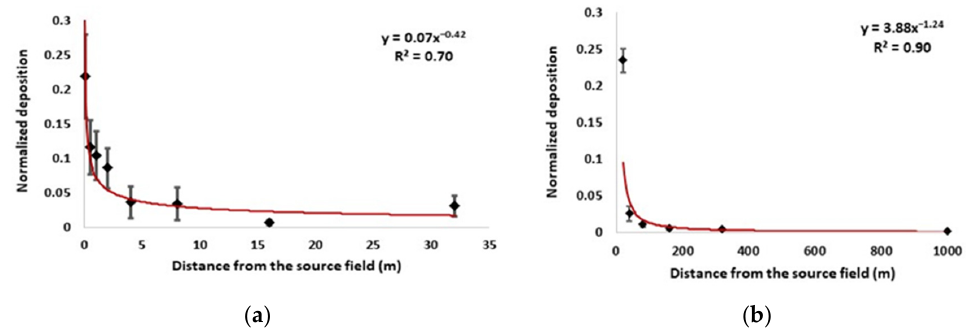
Figure 9. Normalized seed deposition along the downwind direction in the field experiments; x-axis was distance from the source field edge (seed deposition was normalized by the source strength; the diamonds are means and bars are standard deviations; red line is the fitted trend line). ( a ) Normalized seed deposition along the downwind direction in the Tennessee field from 0 to 32 m away from the field edge; ( b ) Normalized seed deposition along the downwind direction in the Illinois field from 20 to 1000 m away from the field edge.